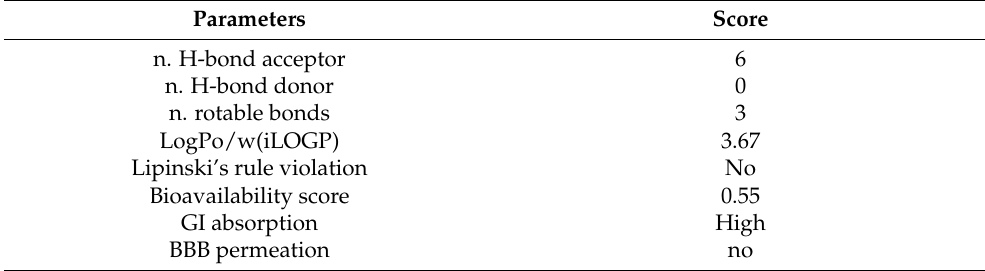
Table 3 . ADME predictions of compound 6b .